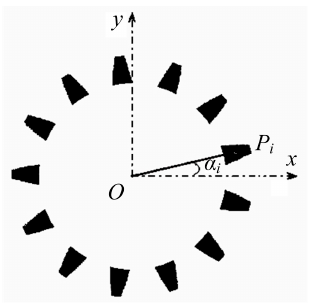
Figure 14. Calculation of gear rotation angle.